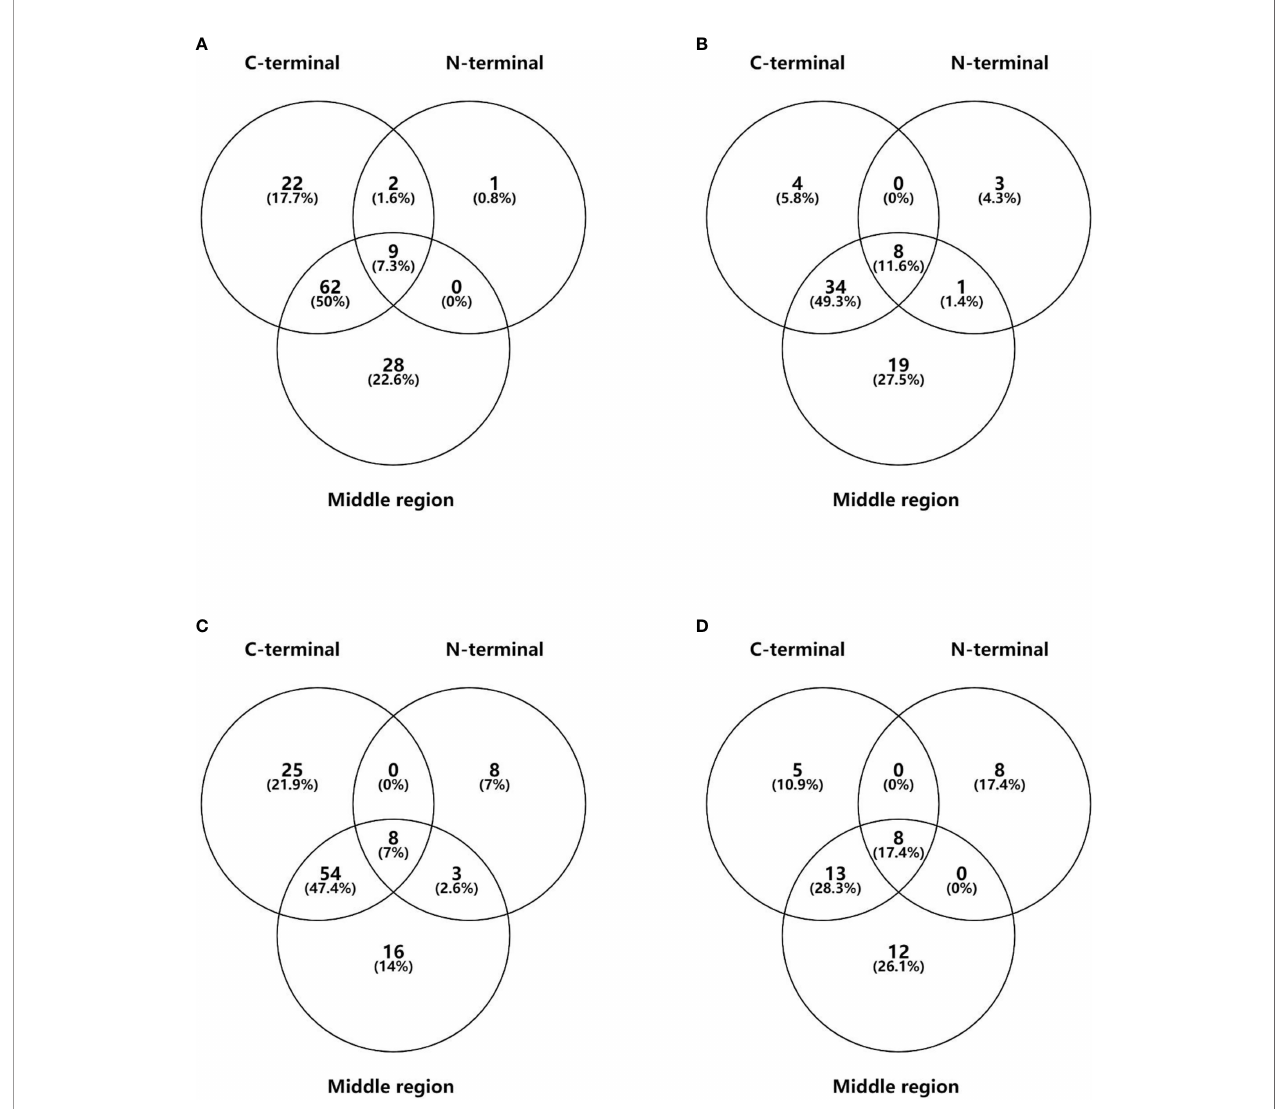
FIGURE 2 | The distribution of GADA binding to different epitopes of GAD65 in young T1DM (A) , LADY (B) , old T1DM (C) , and LADA (D) patients. Data are expressed as n